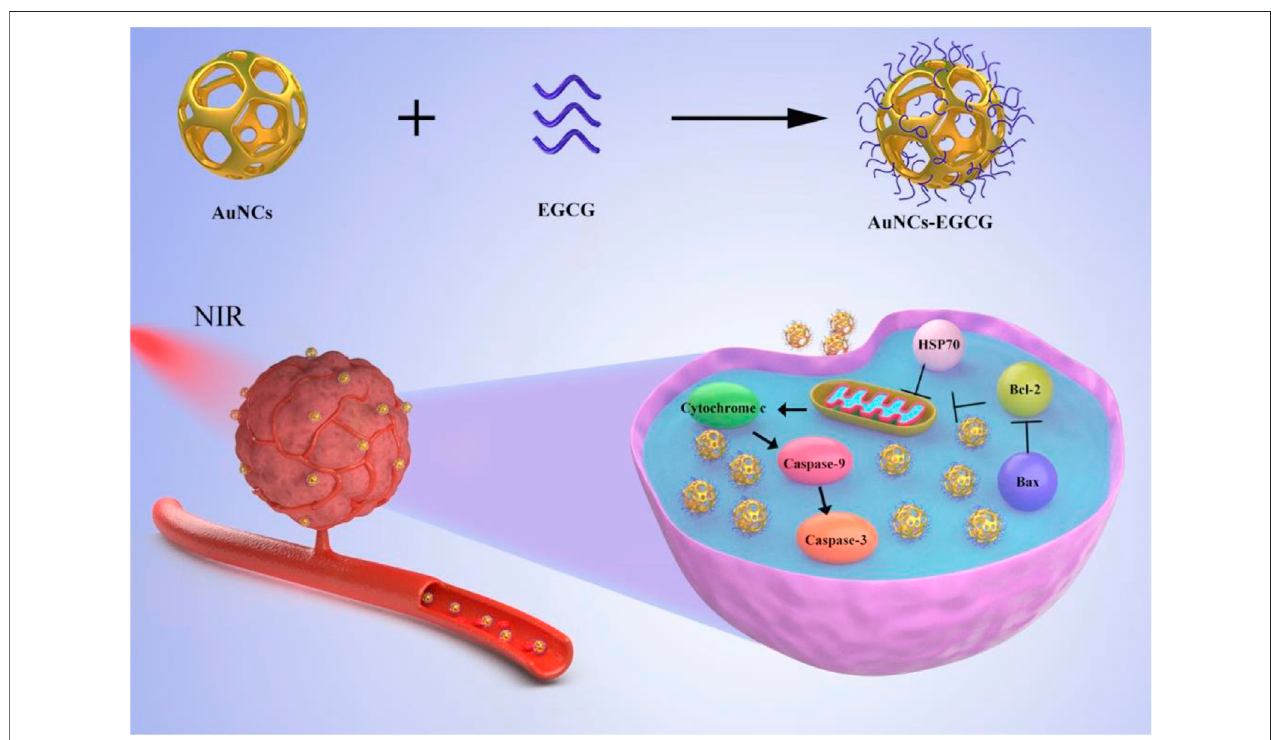
SCHEME 1 | Schematic diagram of the synthesis of AuNCs-EGCG and its effect on cells under near-infrared radiation. AuNCs-EGCG can promote tumor cell